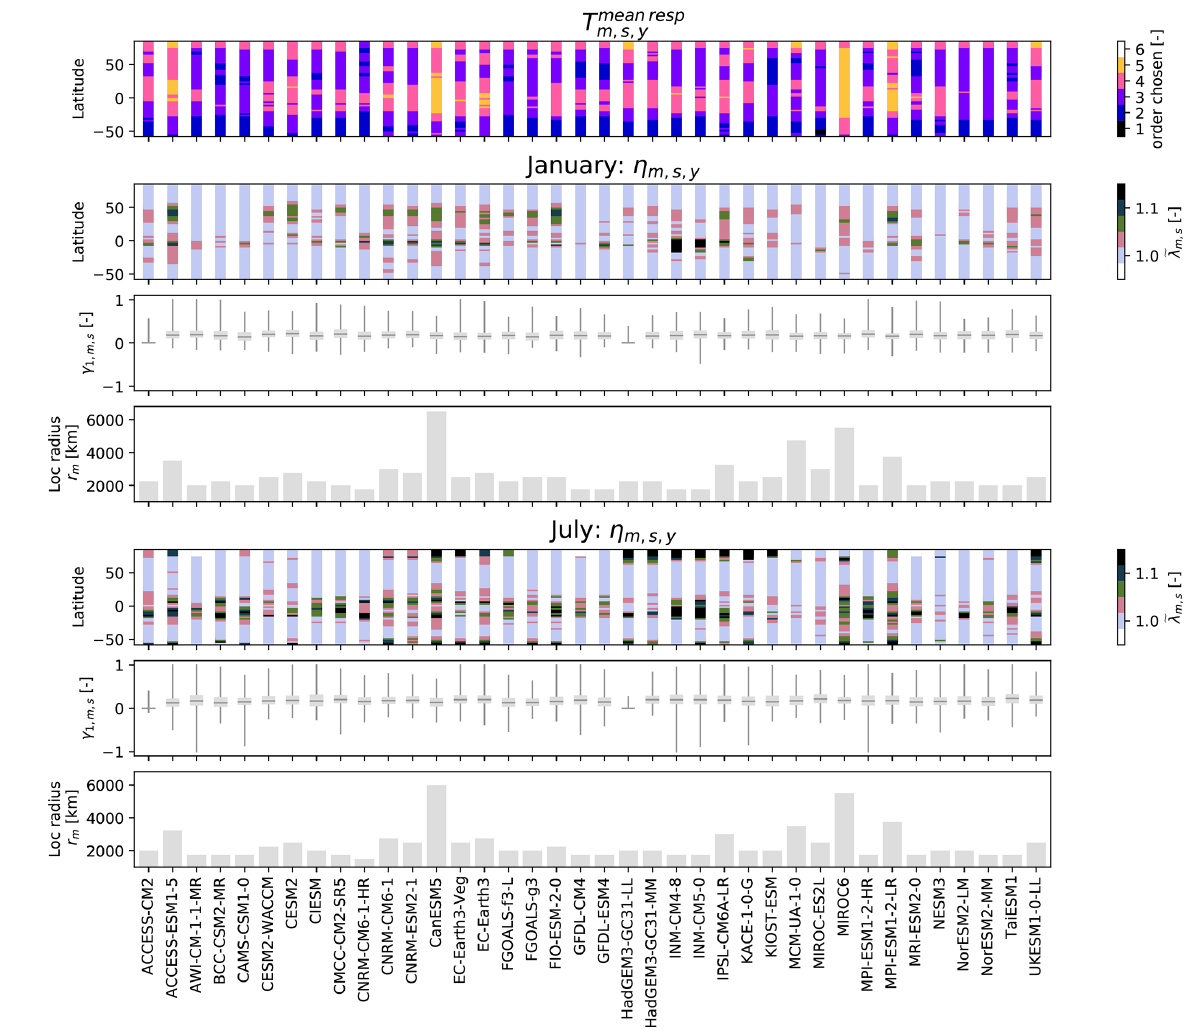
Figure 2. Calibration parameters obtained from emulator fittings for all CMIP6 models. For the mean response module, the latitudinally averaged order of the Fourier series considered in the harmonic model is plotted against latitude (row 1). For the monthly residual variability module, parameters are displayed for January (rows 2–4) and July (rows 5–7). λ m,s,y coefficients averaged over latitude and all years for the local Yeo–Johnson transformation are plotted against latitude (rows 2 and 4). The local lag-1 autocorrelation coefficients ( γ 1 ,m,s ) are plotted as boxplots (rows 3 and 6) with whiskers covering the 0 to 1 quantile range, and the localization radii ( r m ) are given as bar charts (rows 4 and